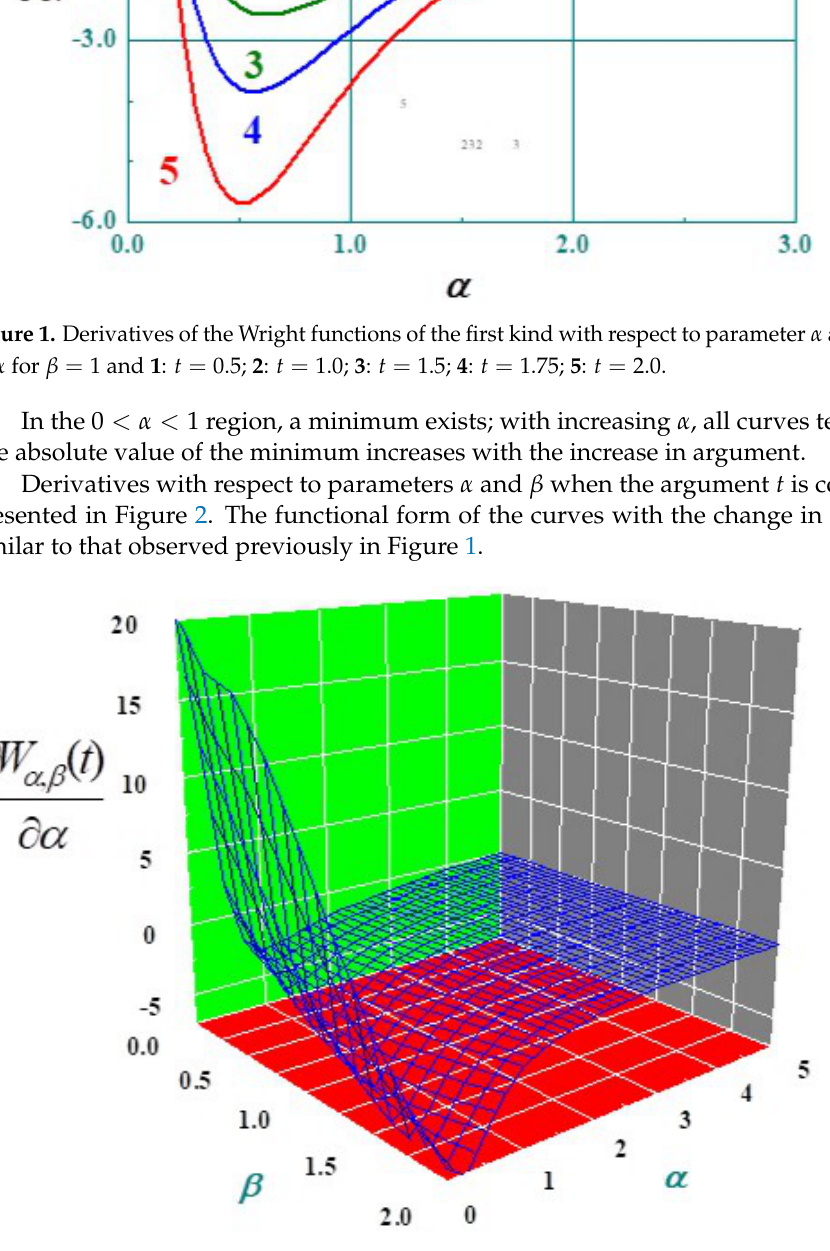
Figure 2. Derivatives of the Wright functions of the first kind with respect to parameter α as a function of α and β = 1 for t =